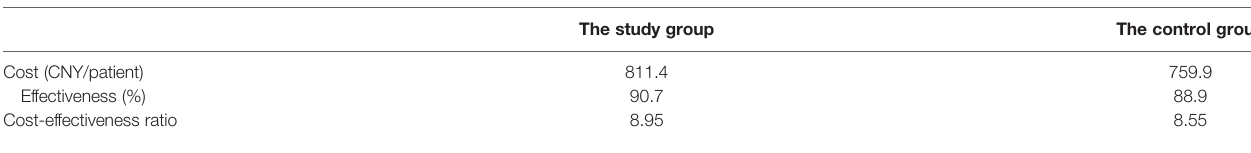
TABLE 7 | Adverse events of two therapeutic